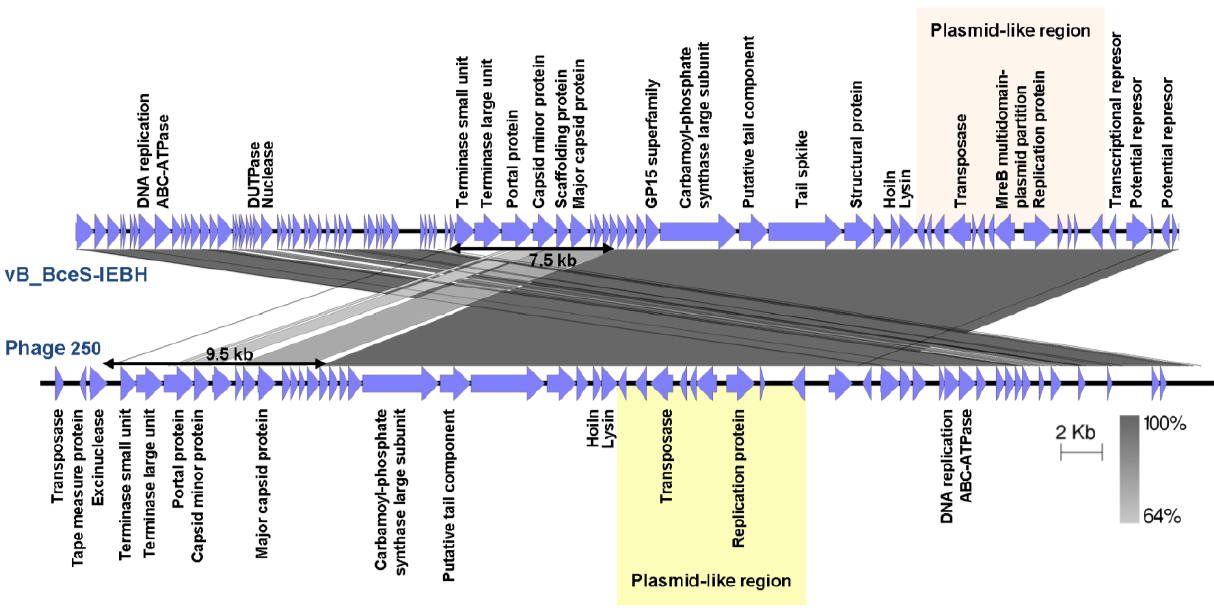
Figure 5. Genome comparisons of phages vB_BceS-IEBH and 250. ORFs are plotted as arrows and some predicted gene functions are indicated. The conserved regions are grey-shaded, the color intensity indicating the identity levels (from 64% to 100%). The 7.5- and 9.5-kb regions with the lowest nucleotide identity are indicated by double-head arrows. The plasmid-like regions for vB_BceS-IEBH and 250 are highlighted in rose and yellow boxes, respectively. Comparisons were done by BLASTn, and similarities with E values lower than 0.001 were plotted. The figure was produced using Easyfig 2.1 program [171]. GenBank accession numbers are indicated in Table